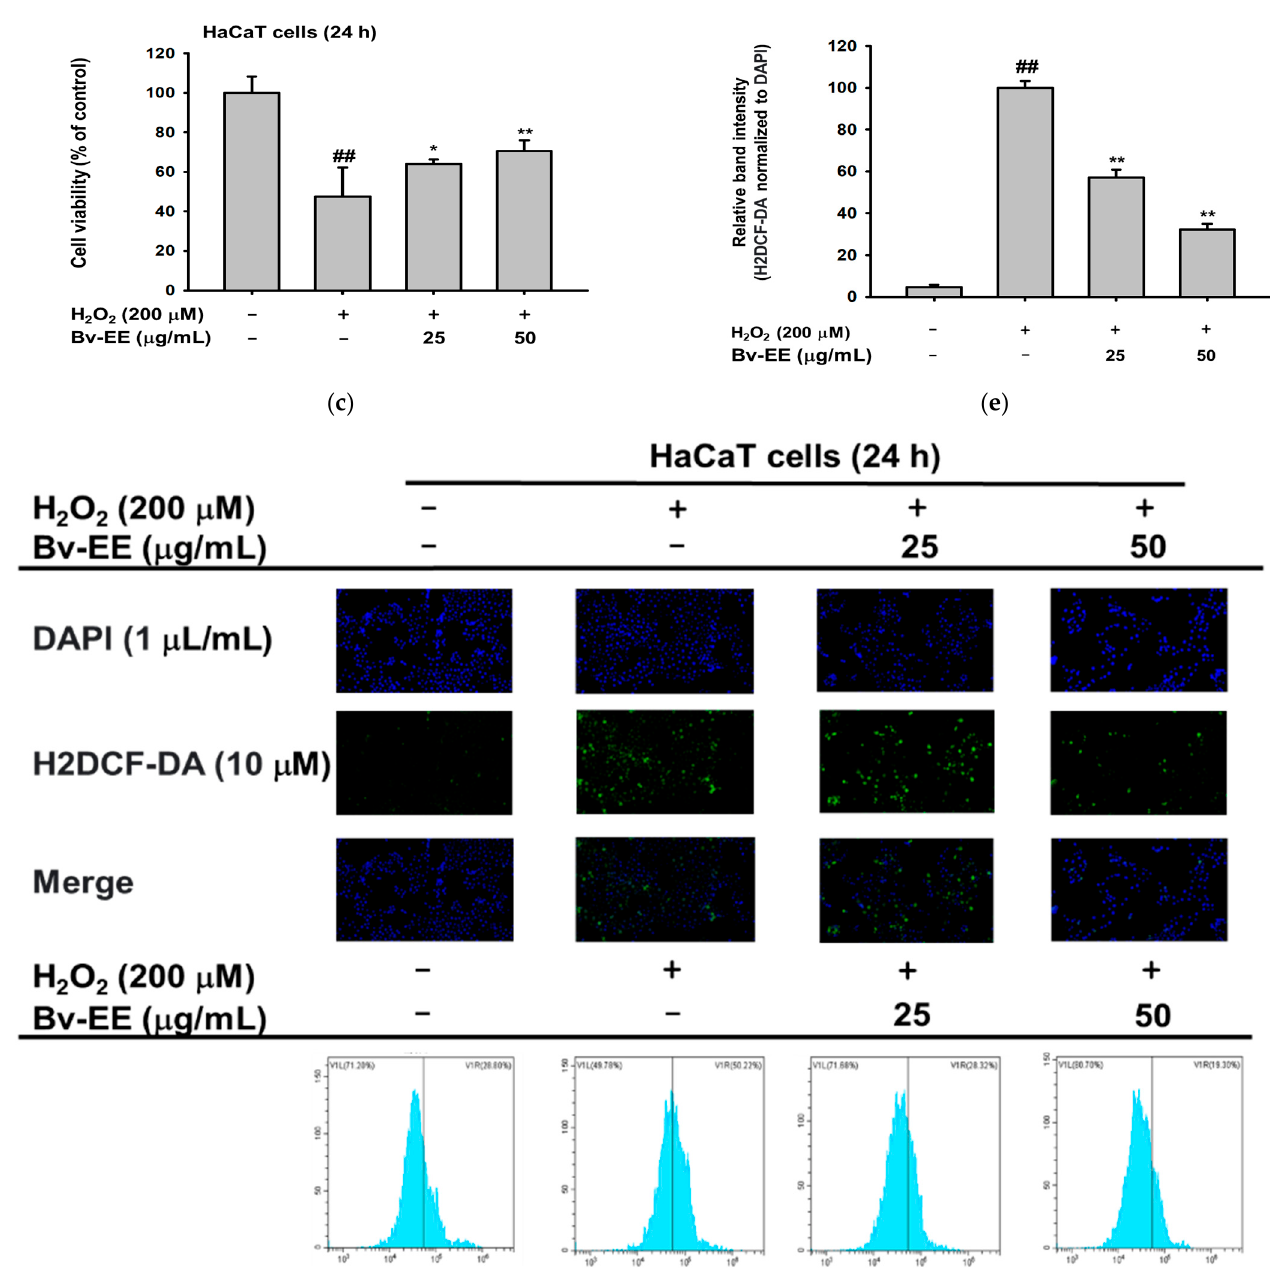
Figure 3. The Bv-EE prevented cell death caused by UVB and H 2 O 2 in HaCaT cells. ( a ) HaCaT cells were treated with different doses of Bv-EE (12.5–200 μ g/mL) for 24 h, and viability was measured using the MTT cell viability assay. ( b ) After UVB exposure (30 mJ/cm 2 ), the cells were treated with Bv-EE for 24 h, and viability was measured using the MTT assay. ( c ) HaCaT cells were pretreated with Bv-EE for 30 min and then subjected to H 2 O 2 (200 μ M) for 24 h. ( d ) The ROS level in HaCaT cells was detected using a fluorescence microscope and flow cytometry. ( e ) The relative intensity of the ROS level was determined using ImageJ. All results are expressed as means ± standard devia- tions. ## p < 0.01 compared with the positive control group, and * p < 0.05, ** p < 0.01 compared with the normal group.